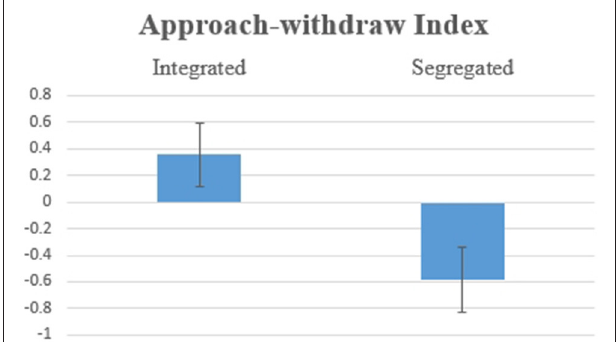
FIGURE 7 | Average values for the Approach Withdraw Index for BP/SN, two pieces of information integrated vs. segregated. The difference was statistically significant at F (1,17) = 11.373, p = 0.004.